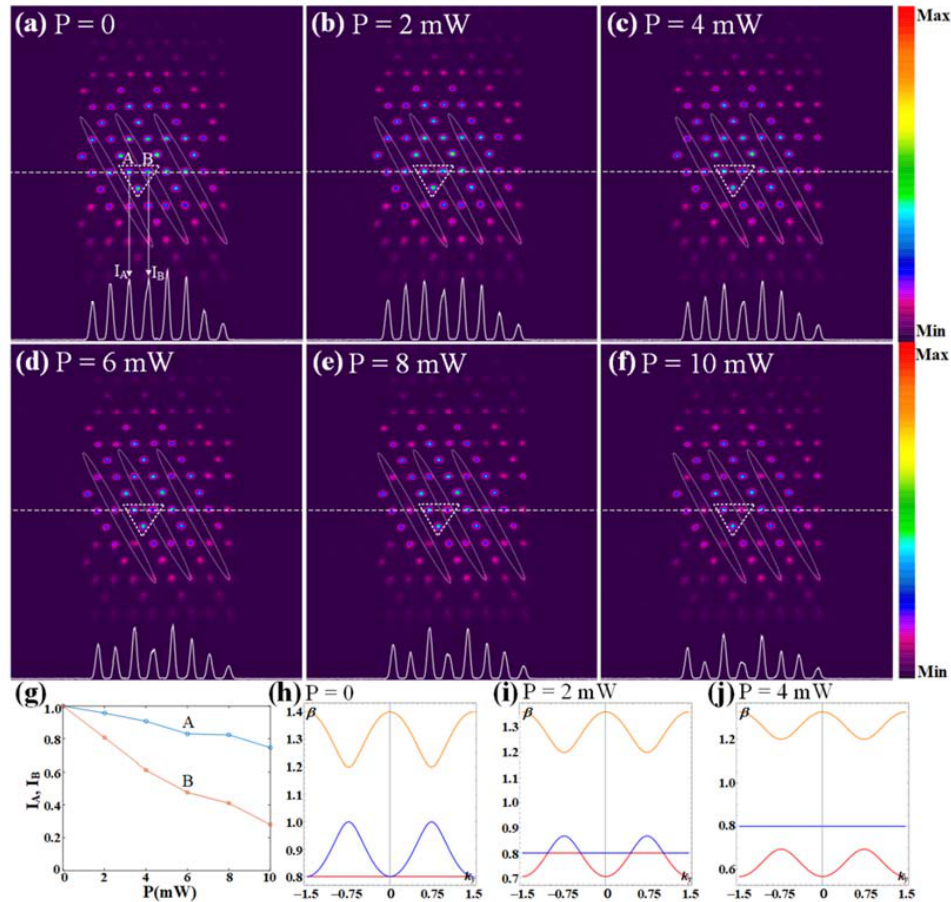
Figure 5. ( a – f ) Evolution of the output probe field with the power of the coupling field E c2 increases from 0 to 10 mW. The B sublattices of the Kagome lattices are covered by E c2 , whose position is indicated by dotted ellipses. The two-photon detuning of two coupling fields E c1 and E c2 is fixed at ∆ − 10 MHz and δ δ p = 100 MHz. The power of the probe field c1 = c2 = 10 MHz respectively, with E p and the Kagome coupling field E c1 are 1mW and 20 mW, respectively. ( g ) The dependences of intensity at A and B sites [marked by two arrows in ( a )] on the power. ( h – j ) The evolution of the type-III Dirac band structures with increasing the power of the one-dimensional coupling field E c2 , and the power corresponding to ( h – j ) are 0, 2 mW, and 4 mW,